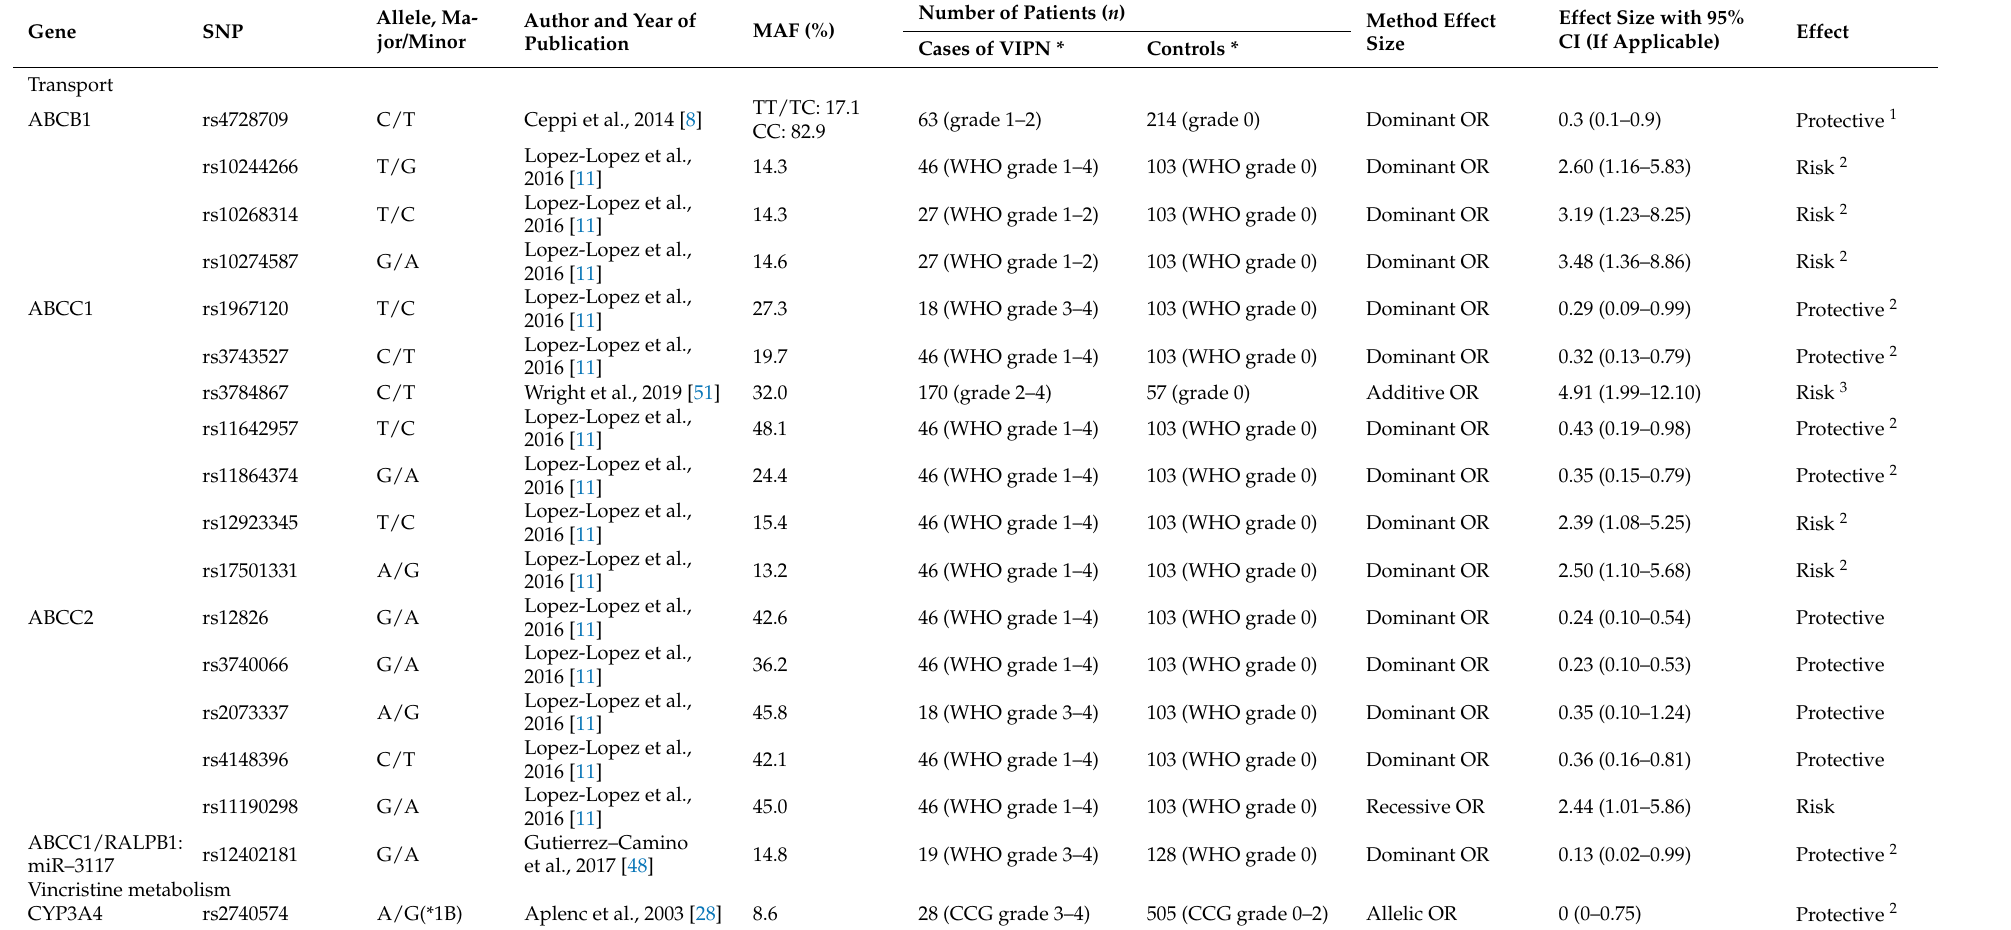
Table 2. Single-nucleotide polymorphisms that were significantly associated with vincristine-induced peripheral neuropathy in the pediatric oncology